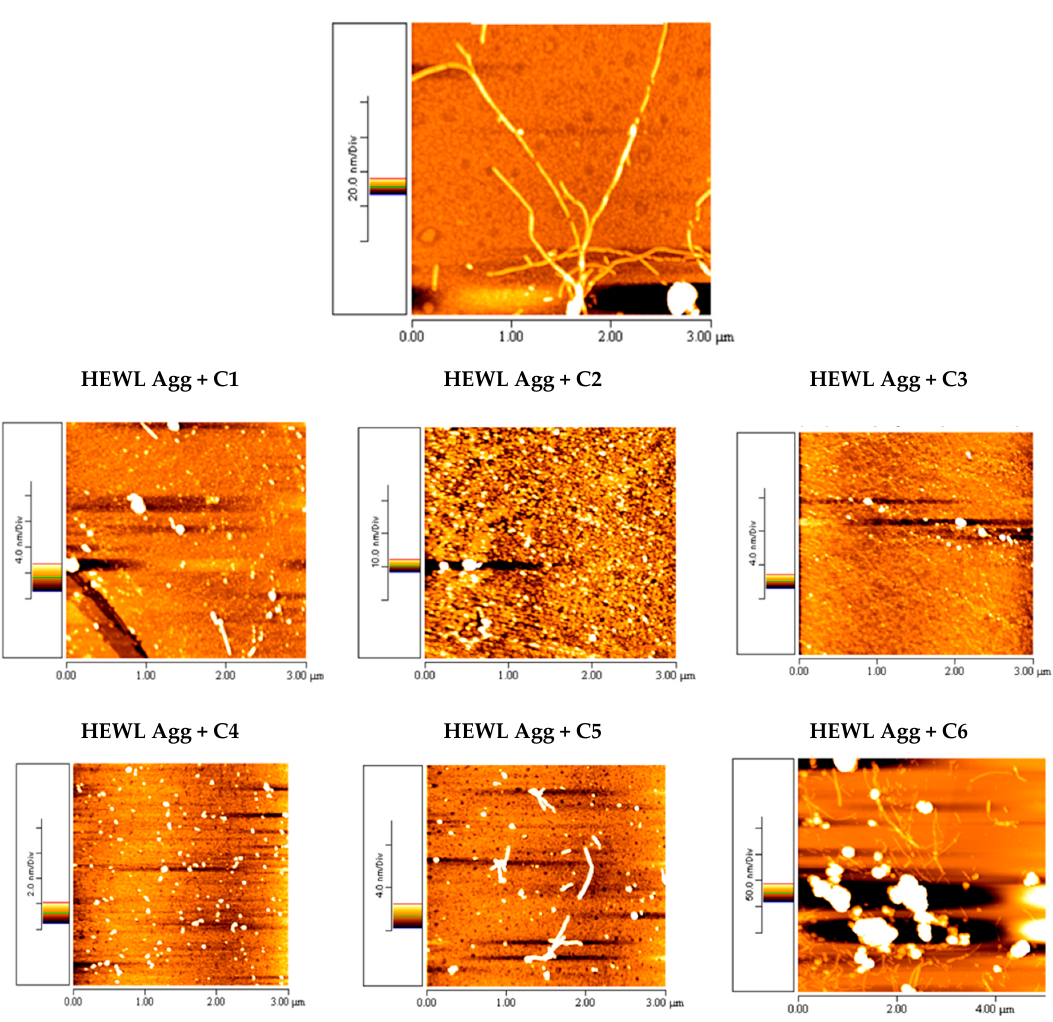
Figure 6. Atomic force microscopy (AFM) images of HEWL aggregates formed in absence or presence of compounds 1–6. HEWL was pre-incubated under conditions promoting amyloid fibril formation that is 48 h at a concentration of 140 µM, in 50 mM glycine buffer, pH 2.5, 57 °C, under stirring (250 rpm), in the absence or presence of 0.32 µM compounds 1–6.